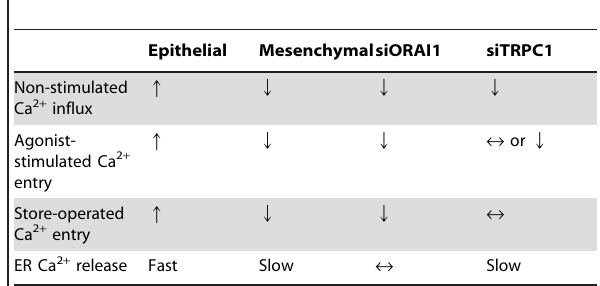
Table 1. Summary of changes in Ca 2 + homeostasis with EGF- induced EMT and silencing of ORAI1 (siORAI1) or TRPC1